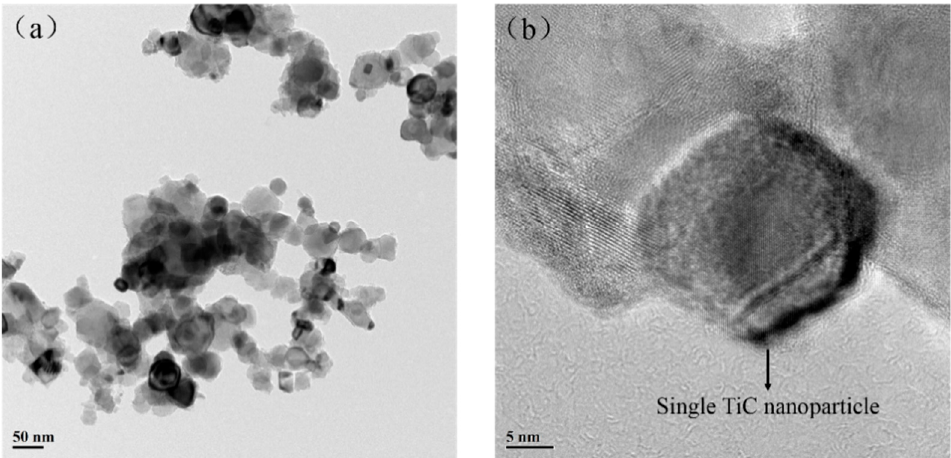
Figure 1. The TEM examination of as-received TiC nanoparticles: ( a ) morphology of TiC